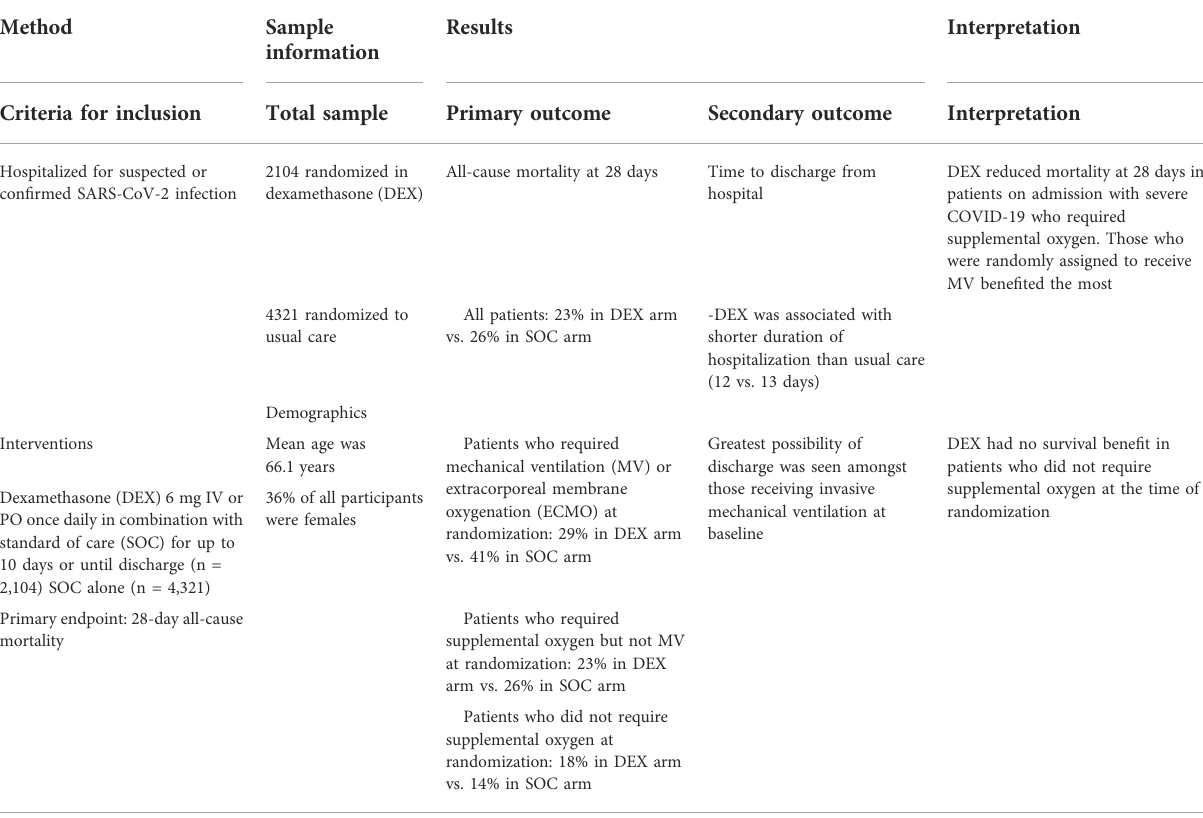
TABLE 1 Summary of the open-label RCT of dexamethasone in hospitalized patients with COVID-19 in the United Kingdom (Horby et al.,